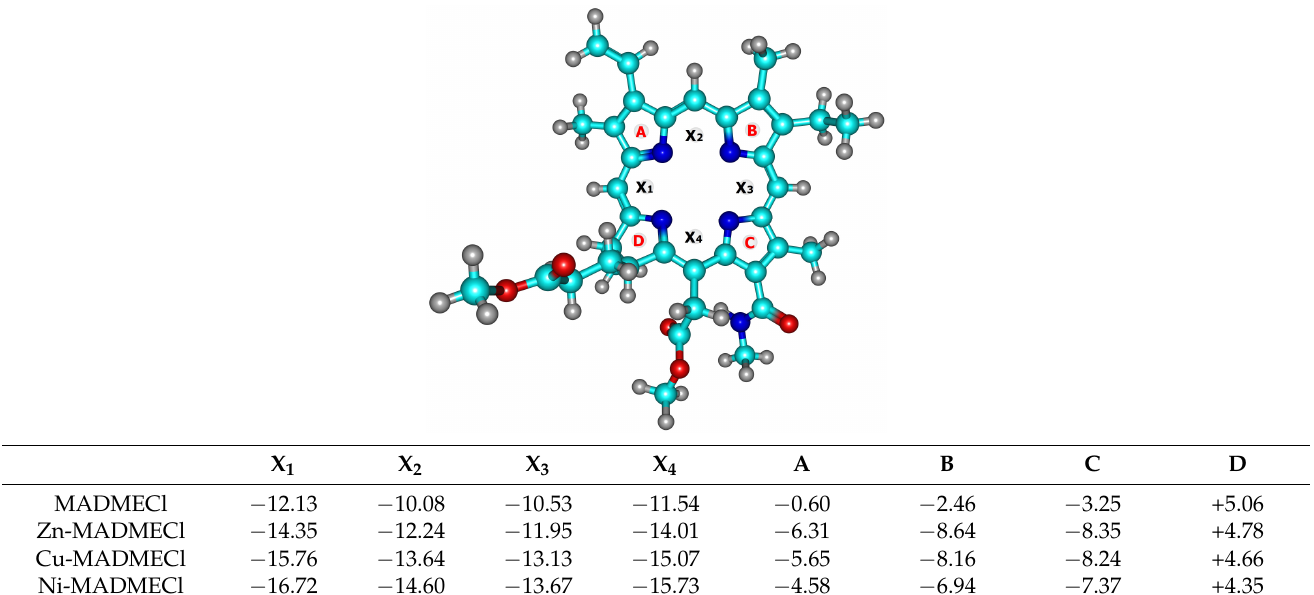
Table 3. NICS parameters (ppm).